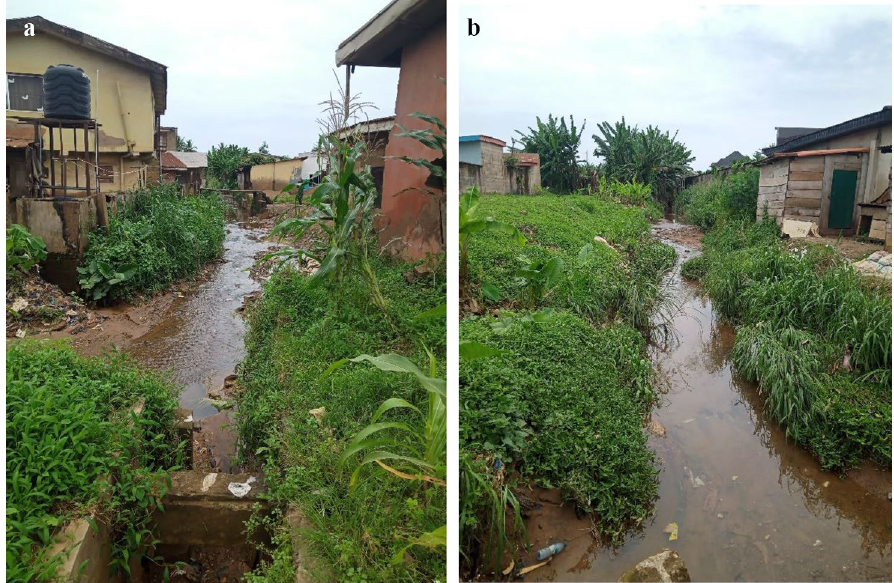
Fig. 5 Typical channel condi- tions in some urban streams showing evidence of build- ing encroachment along the stream corridor at a Fadeyi and b Osinle areas in